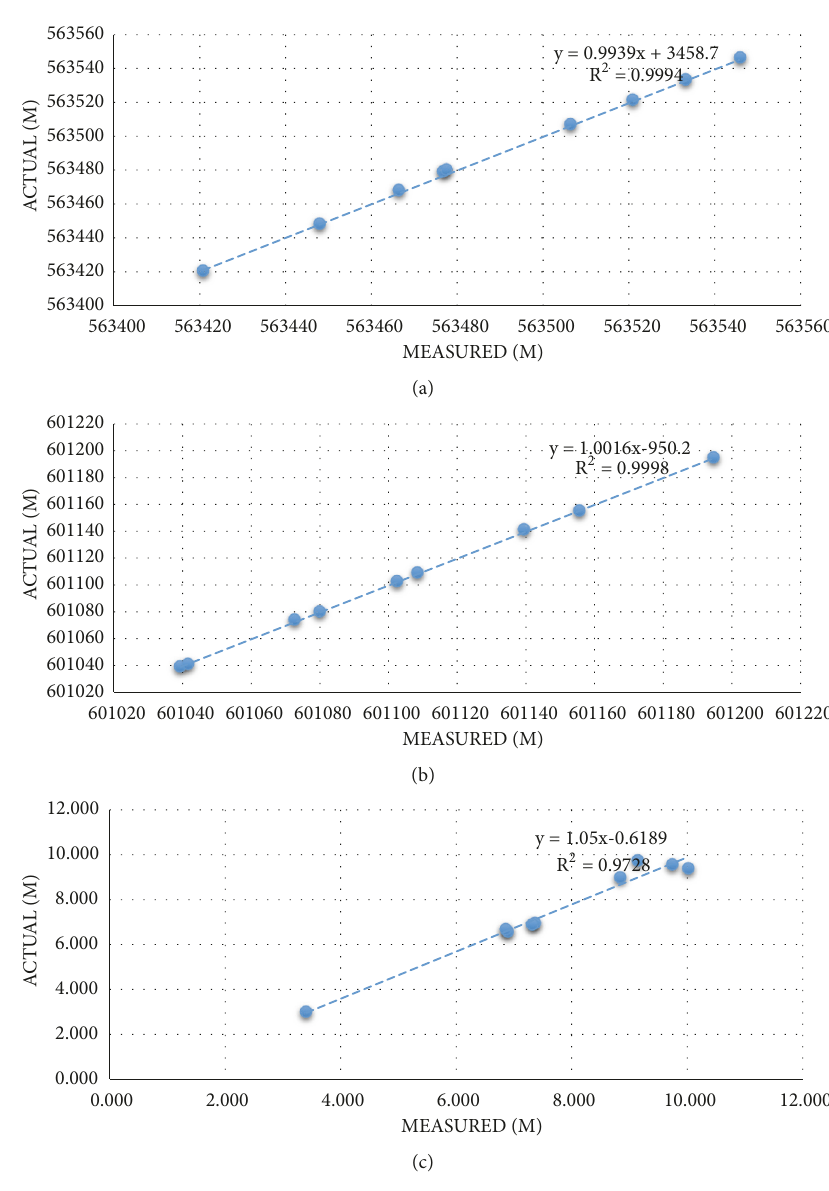
Figure 11: Linear regression: (a) X coordinate, (b) Y coordinate, and (c) Z